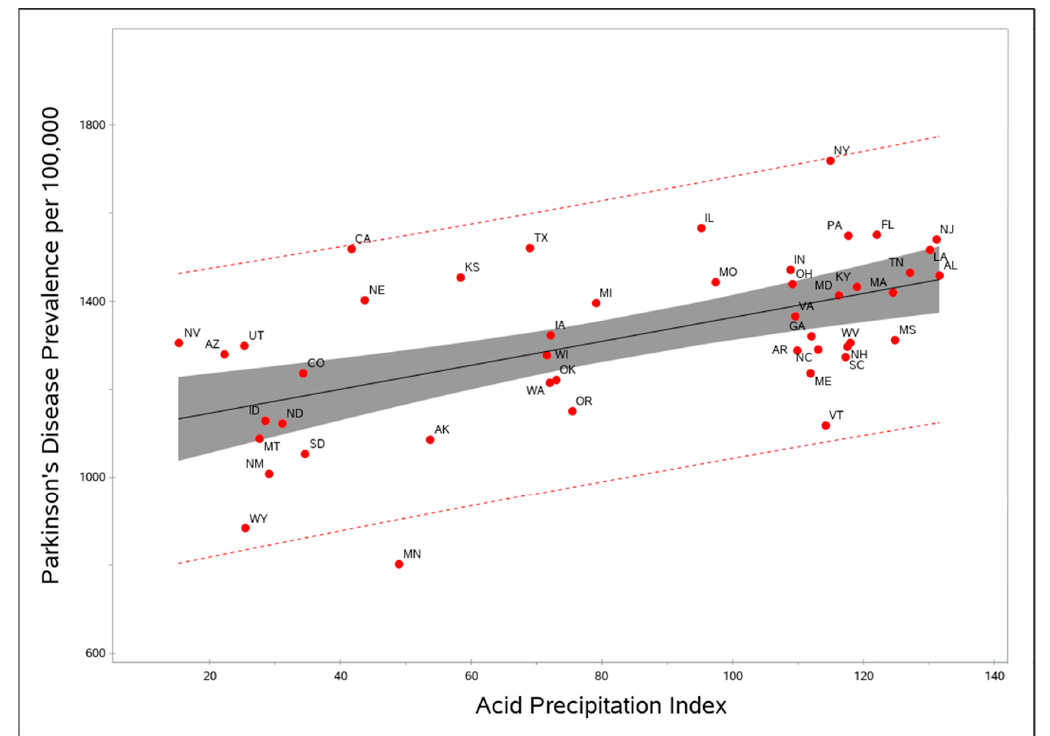
Figure 1. State-level prevalence of Parkinson’s disease vs. the quantity of acid rain, measured by the Acid Precipitation Index. Confidence limits of the mean and dotted lines are 95% confidence intervals.